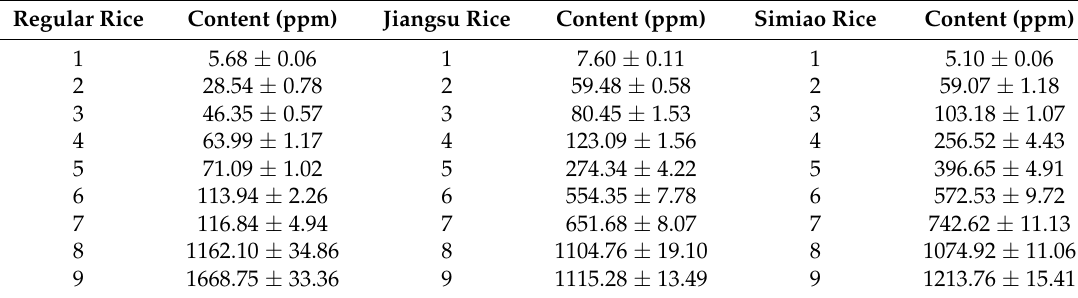
Table 1. Reference values of Cu concentrations and uncertainties detected by FAAS